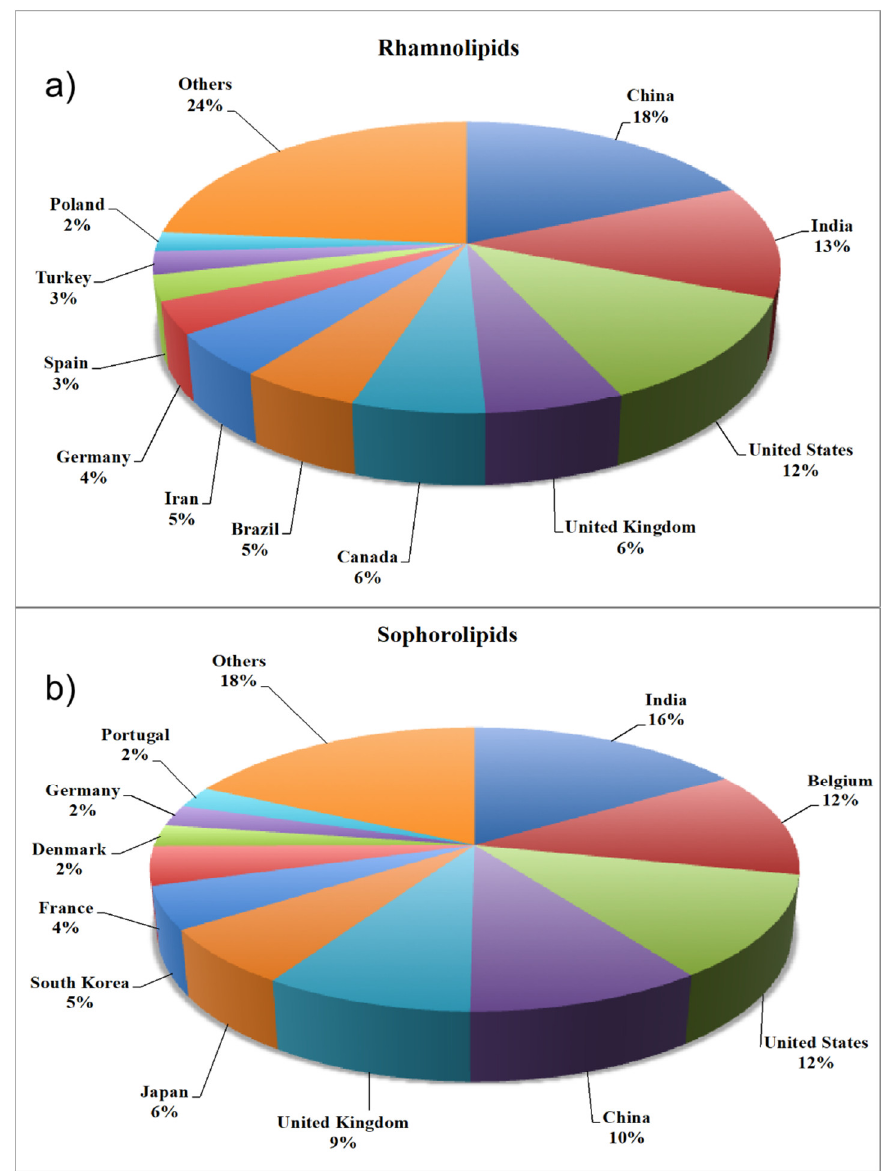
Figure 2. Distribution of published works regarding ( a ) rhamnolipids and ( b ) sophorolipids, by country.